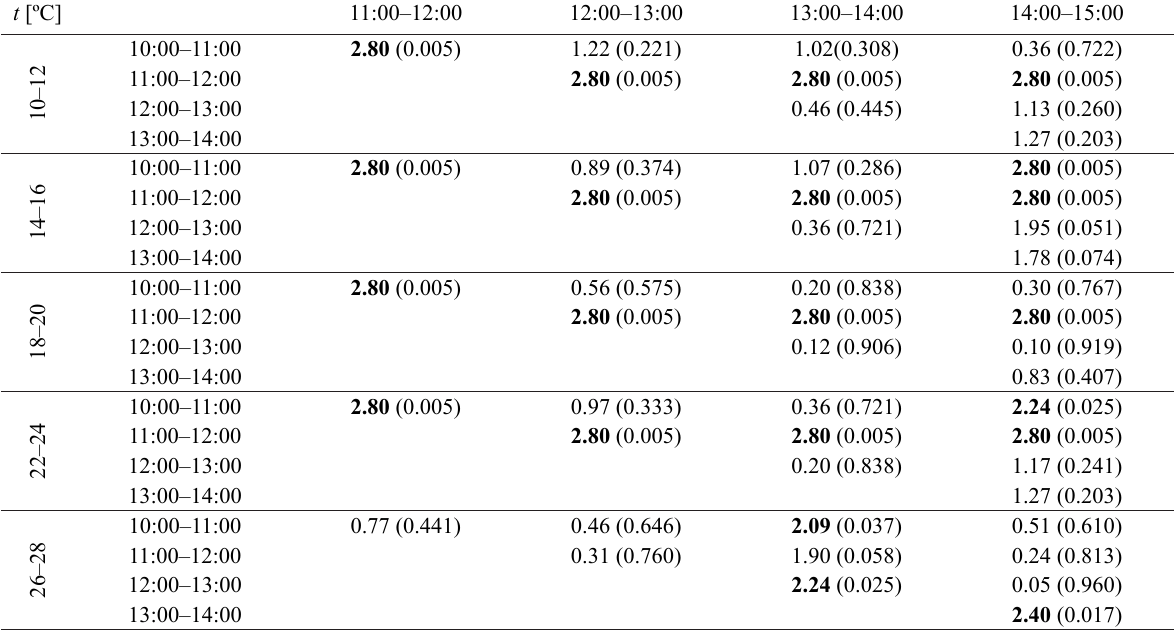
Matrices of Mann–Whitney U -test parameters for comparing the activity (mean number of movements per hour) of round goby, Neogobius melanostomus , during one hour with normal atmospheric pressure (10:00–11:00 h, 13:00– 15:00 h) and with the atmospheric pressure increased by 1333 Pa (11:00–13:00